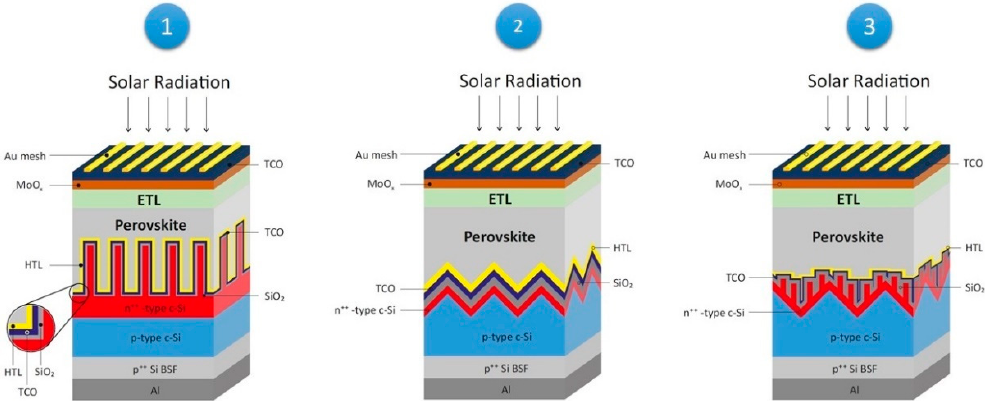
Figure 2. The proposed TSC structures contains a pyramidal textured ( 1 ), µ -wires structured ( 2 ), and hybrid texture/ µ -wires structured ( 3 ) c-Si bottom sub-cell with the recombination layer and perovskite as a top sub-cell.